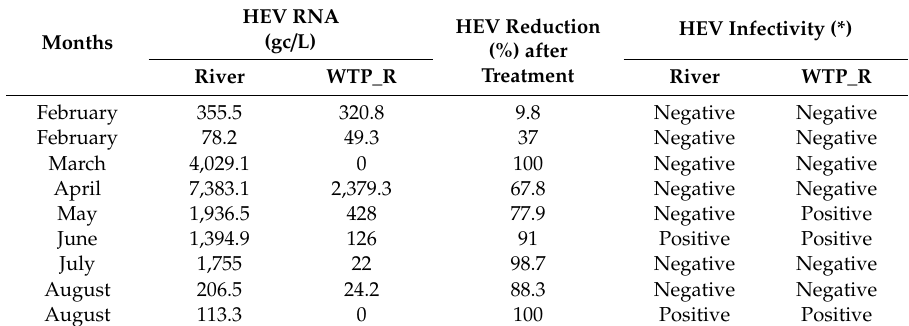
Table 3. Evaluation of related concentrated water samples (river and WTP_R) for the presence of HEV RNA and infectious particles.